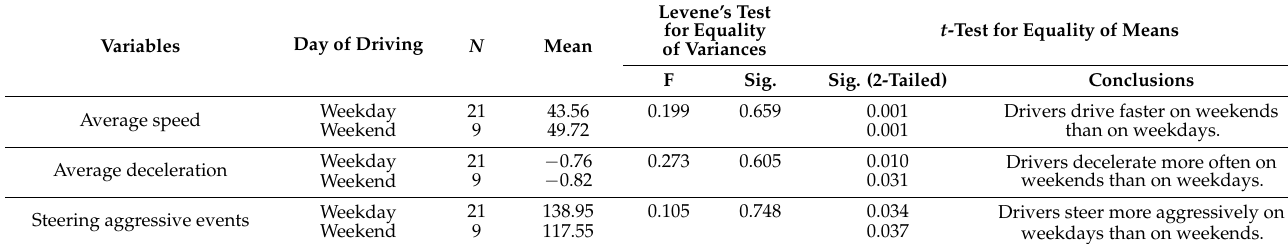
Table 6. Statistical differences in driving day group.